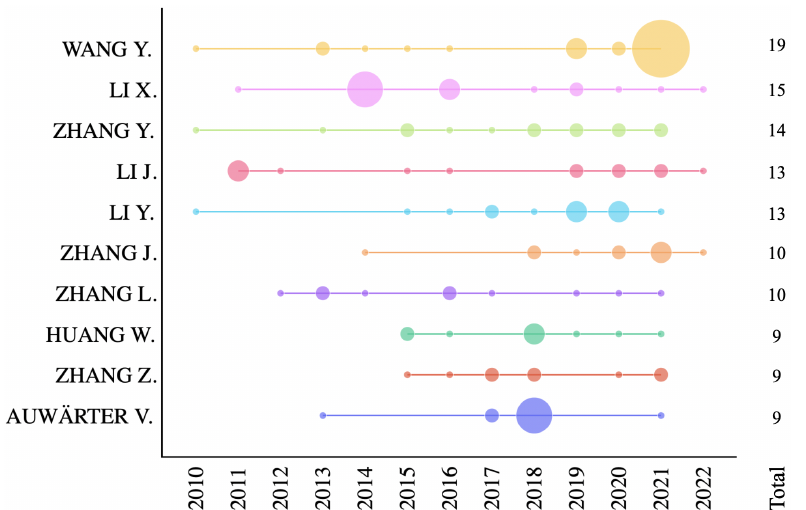
Figure 4. Most published authors. The y -axis represents the authors with the most publications by decreasing order—the total number of publications of each author is on the right. The x -axis represents the year of publication. The area of the circles is proportional to the number of publications of a given author in a given year.